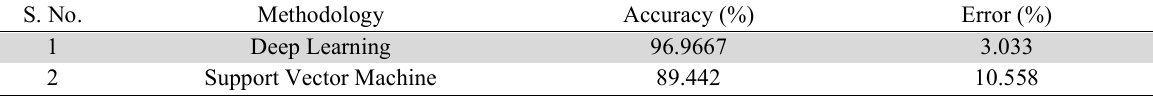
Comparison of the SVM and deep learning results for machining of holes in terms of accuracy and error S.